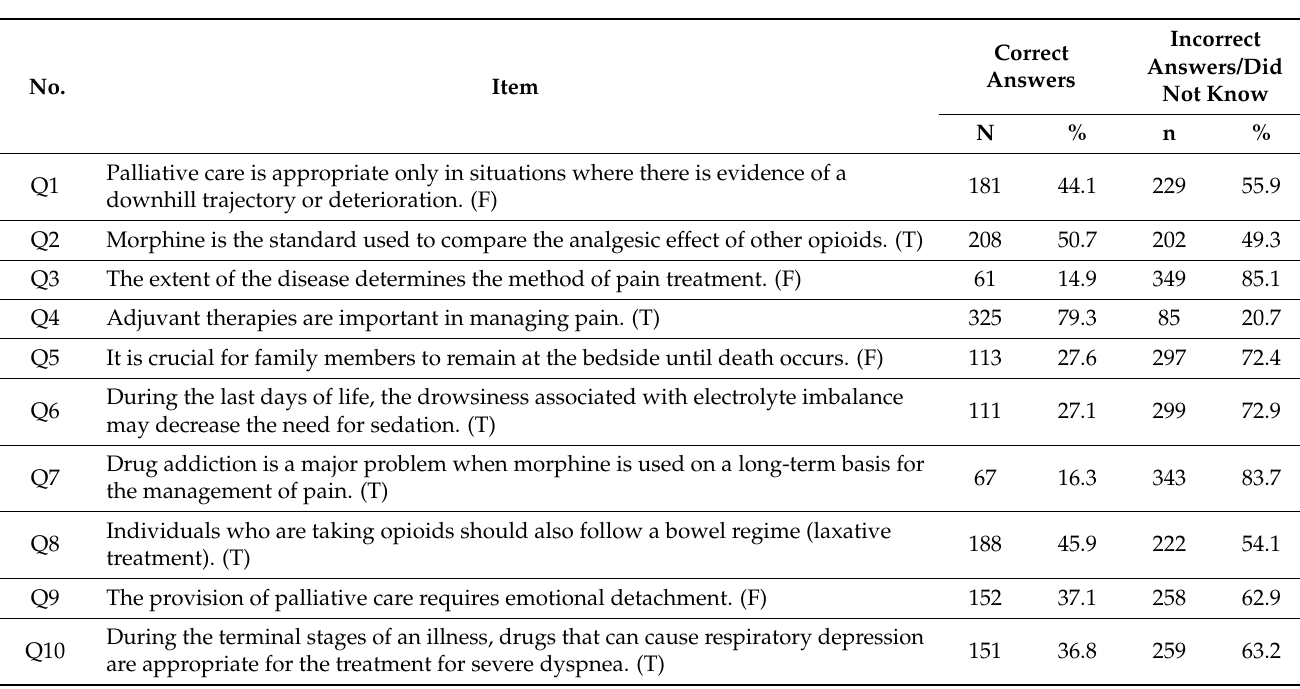
Table 2. Distribution of nursing students’ knowledge about palliative care (n =